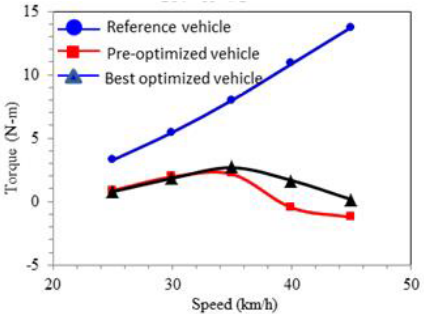
Figure 19. Steering torque simulation on the steady